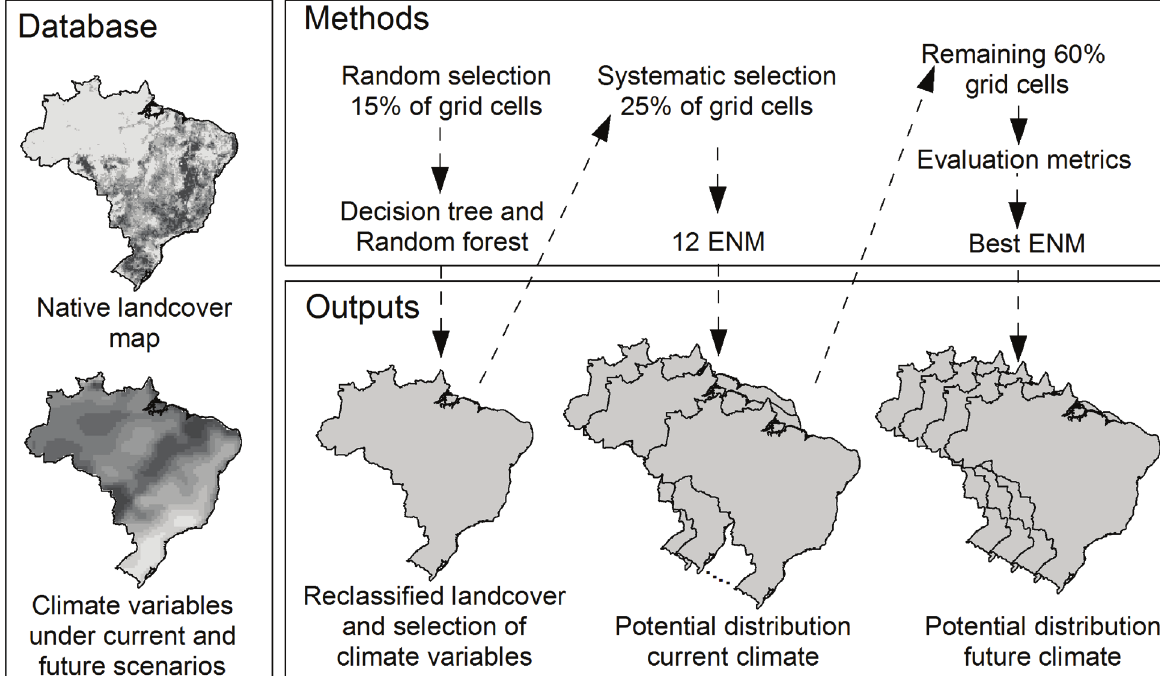
Figure 1 - Schematic approach applied in this study to understand the main environmental alterations under Brazilian biomes mediated by future climate change.